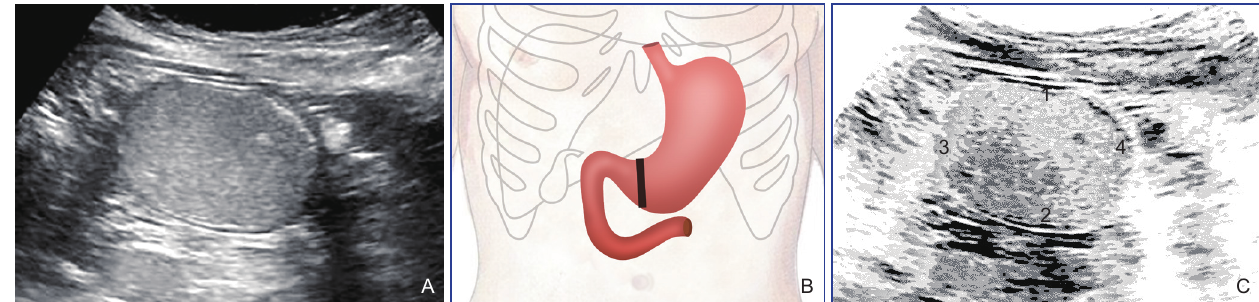
Figure 10 Ultrasonogram and schematic diagram of the short axial section of the gastric angle (scanning under xiphoid process). A, Ultrasonogram; B, Schematic diagram; C, Schematic diagram of ultrasound (1, Anterior gastric wall;2, Posterior gastric wall;3, Lesser curvature; 4, Greater curvature)